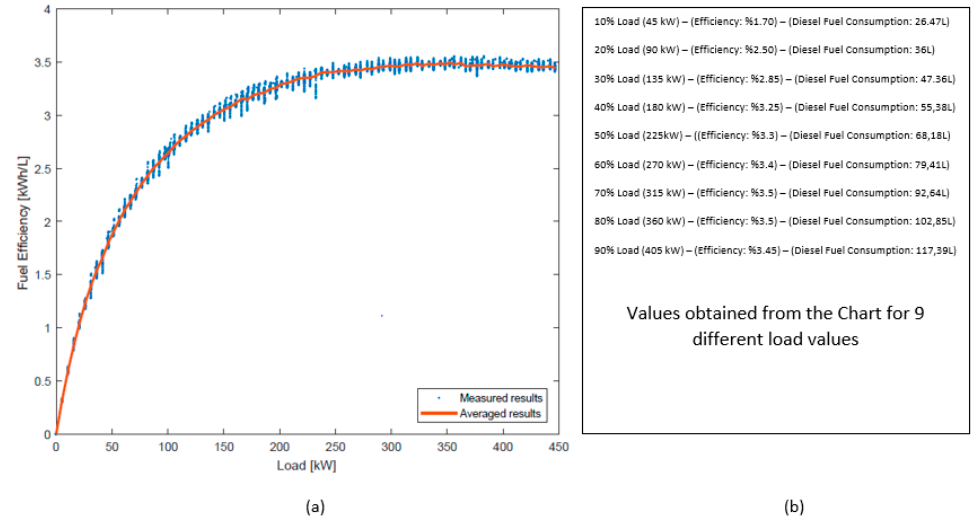
Figure 1. Diesel generator fuel efficiency curve (This curve is from ACEP documentation [7]): ( a ) The relation between Load (kW) rate and Fuel Efficiency (kWh/L); ( b ) Values obtained from the Chart.